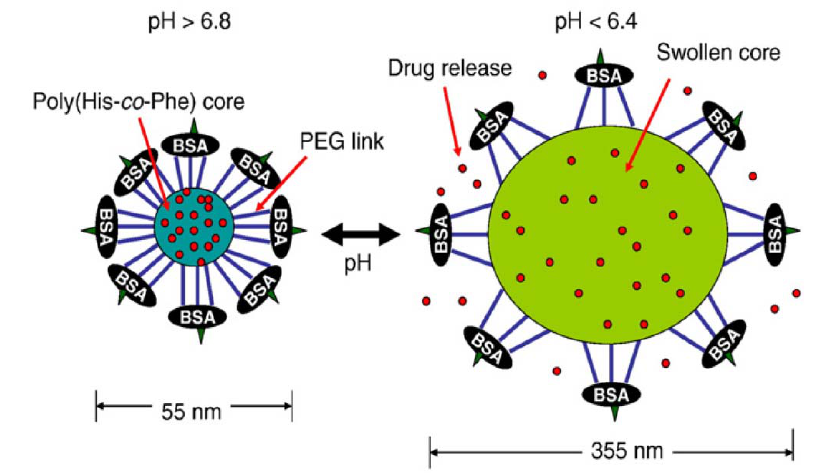
Figure 4. Schematic presentation of the virogels. See text for details. Reproduced with permission from reference